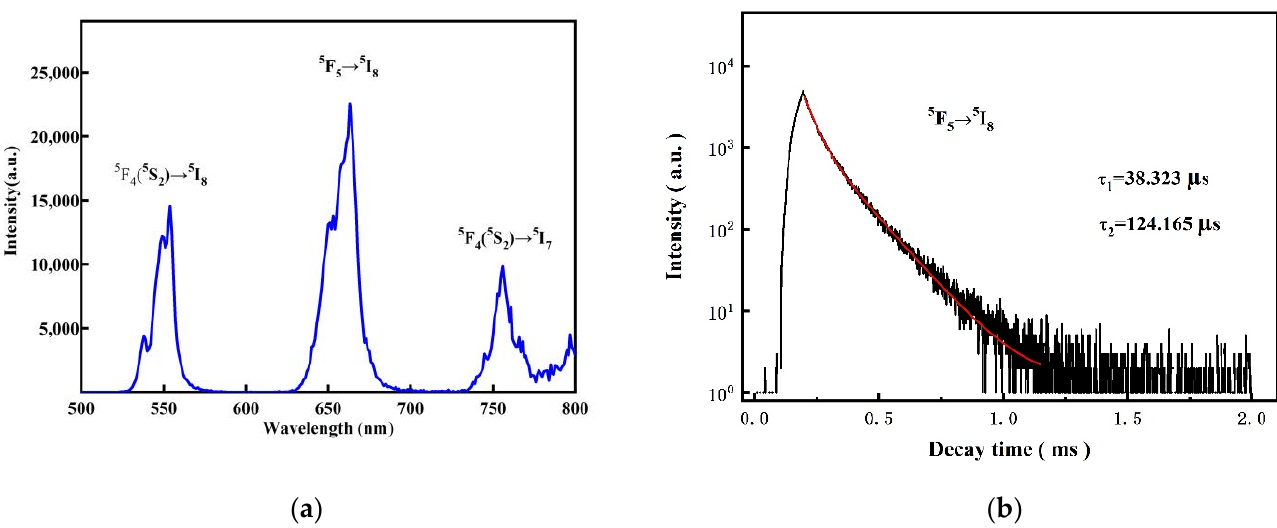
Figure 7. ( a ) UC emission spectra of PMN-32PT:Ho 3+ /Yb 3+ crystals at 980 nm excitation. ( b ) Fluorescence decay curves of Ho 3+ for 5 F 5 → 5 I 8 in PMN-32PT crystals at 980 nm excitation. In addition, the fluorescence decay curves for 5 F 5 → 5 I 8 transitions of Ho 3+ in PMN- 32PT at 663 nm with the excitation of 980nm are shown in Figure 7b. The decay curves exhibited multi-exponential behavior, it can be well fitted with dual exponential function, fluorescence lifetime obtained by Equation (15):